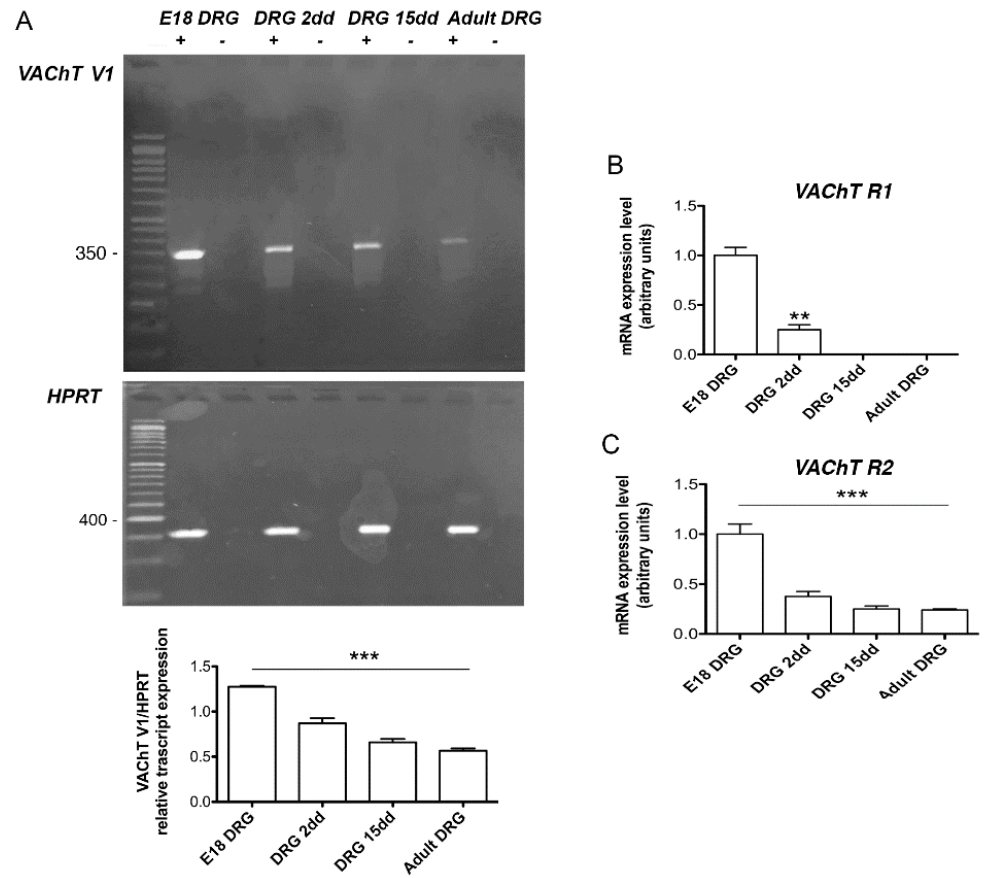
Figure 3. ( A ) Representative RT-PCR analysis of V1 VAChT splice variants at embryo E18, postnatal 2 and 15, and in adult DRG. HPRT was used as a housekeeping gene. The graph below reports the densitometric analysis of the bands normalized with respect to the HPRT housekeeping gene. The data are the mean of three independent experiments (*** p < 0.001); ( B , C ) Analysis by qRT-PCR of the R1 and R2 VAChT splice variants. The samples were compared with the respective E18 DRG sample. The data are the mean of three independent experiments performed in triplicate. (** p < 0.01; *** p < 0.001).